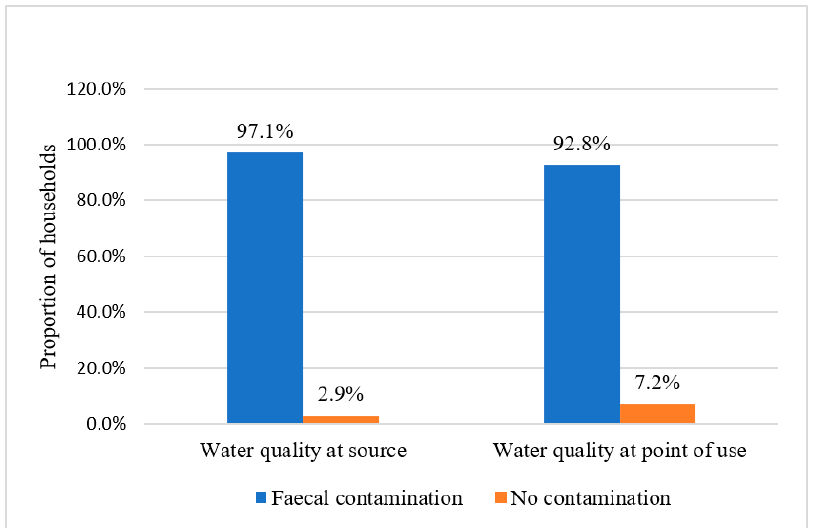
Figure 3. Fecal contamination of water at source and point of use during pre-monsoon season ( N = 210).